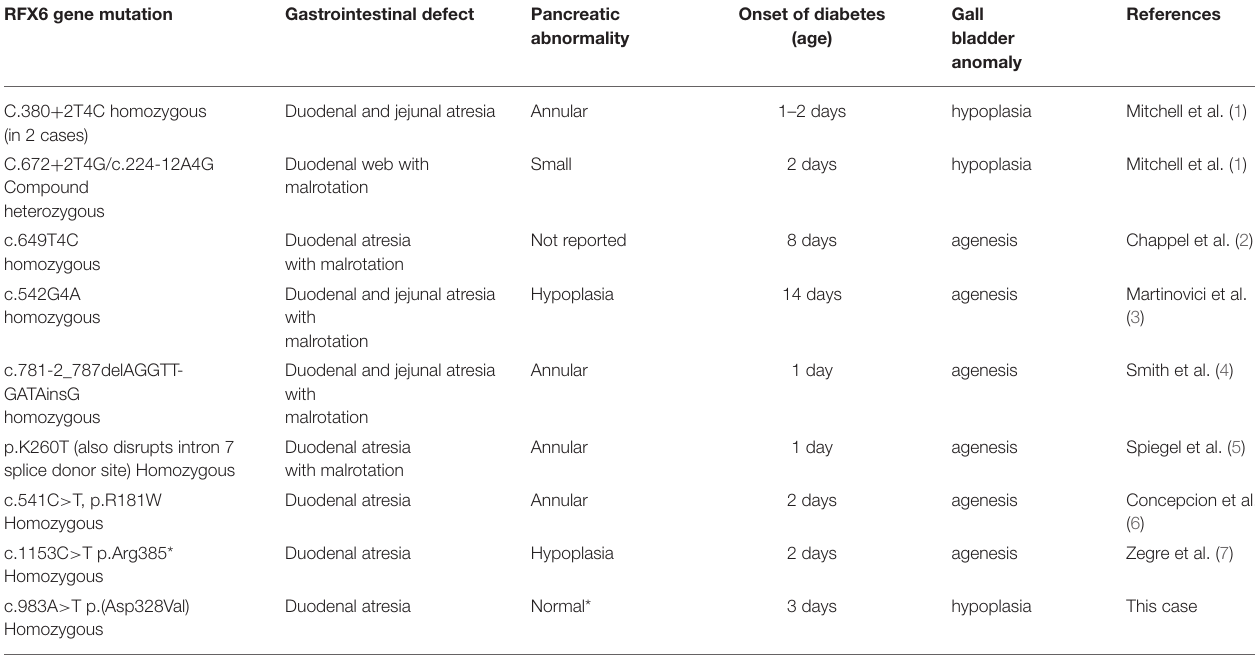
TABLE 2 | The reported RFX6 gene